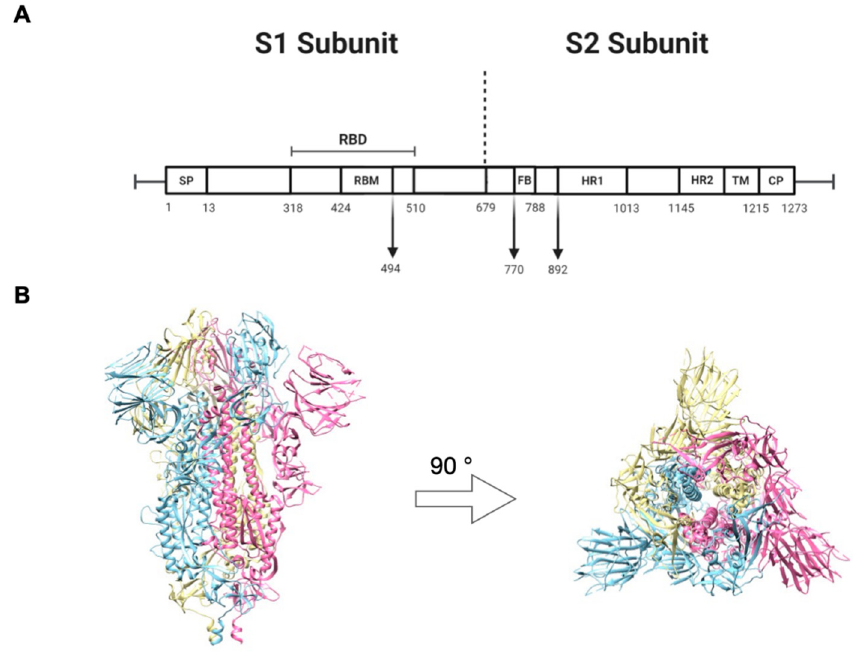
Figure 1. Schematic of the severe acute respiratory syndrome coronavirus 2 (SARS-CoV-2) spike glycoprotein. ( A ) The primary structure of S with its domains: signal peptide (SP), receptor binding domain (RBS), fusion peptide (FP), heptad repeat (HR), transmembrane (TM), and cytoplasmic tail (CT). ( B ) Side and top view of the three-dimensional structure of the trimeric spike protein in the perfusion confirmation. Image created from the structure with Protein Data Bank (PDB) identifier VXX6.